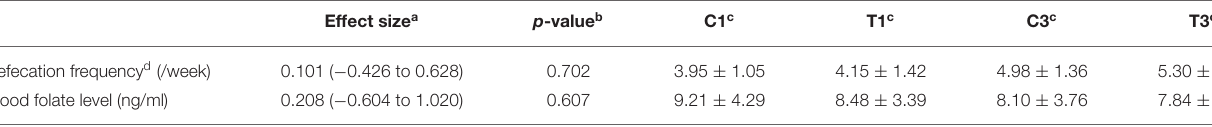
TABLE 1 | Chlorella intake did not significantly increase defecation frequency or blood folate